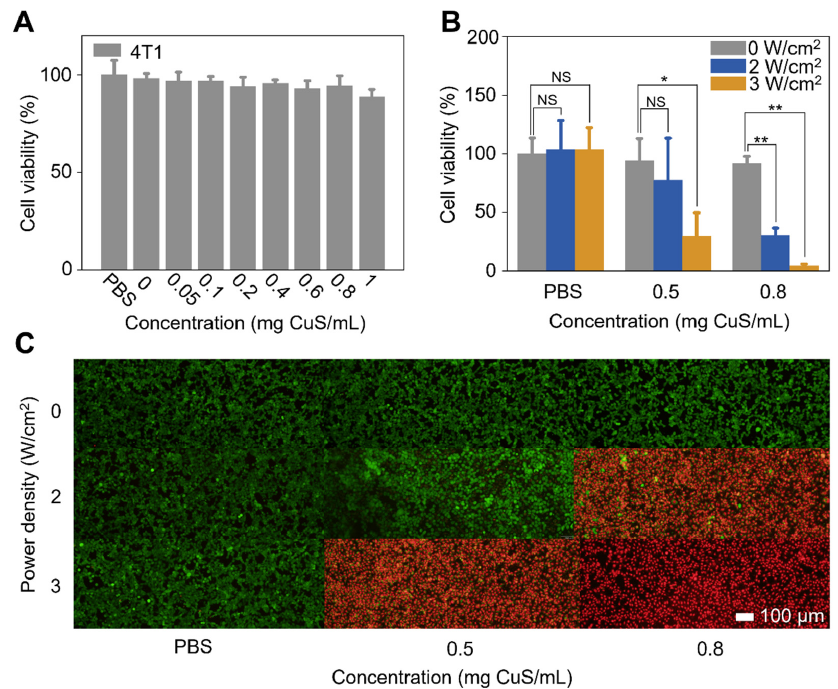
Figure 4. ( A ) Cytotoxicity of 4T1 cells incubated with different concentrations of CSH or PBS. ( B ) Viability of 4T1 cells incubated with PBS or CSH (0.5, 0.8 mg CuS/mL) and irradiated by NIR-II laser (1064 nm: 0, 2, or 3 W/cm 2 ) (* p < 0.05, ** p < 0.01). ( C ) Dead/live cell staining test of 4T1 cells treated with PBS or CSH (0.5, 0.8 mg CuS/mL) and irradiated by NIR-II laser (1064 nm: 0, 2, or 3 W/cm 2 ).